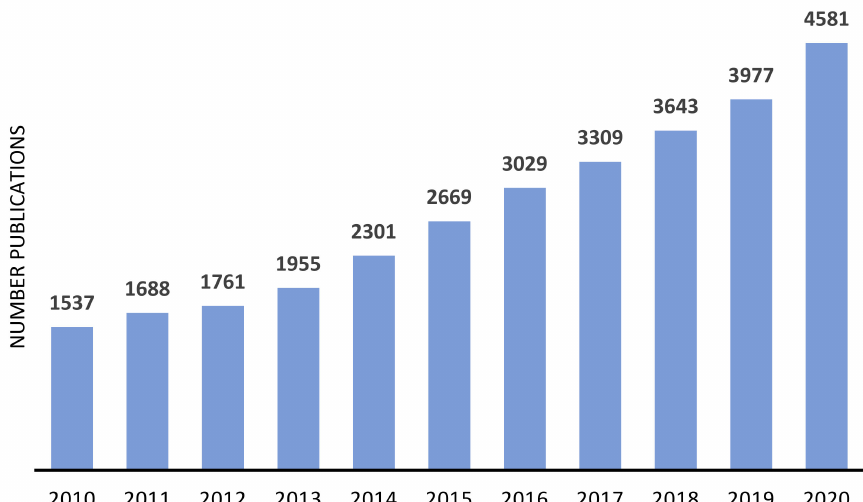
Figure 6. Approximate annual number of publications on metal supported on zeolites and other similar materials, since 2010. Source: ISI Web of Knowledge, 29 September 2021. Search terms: “metal-supported